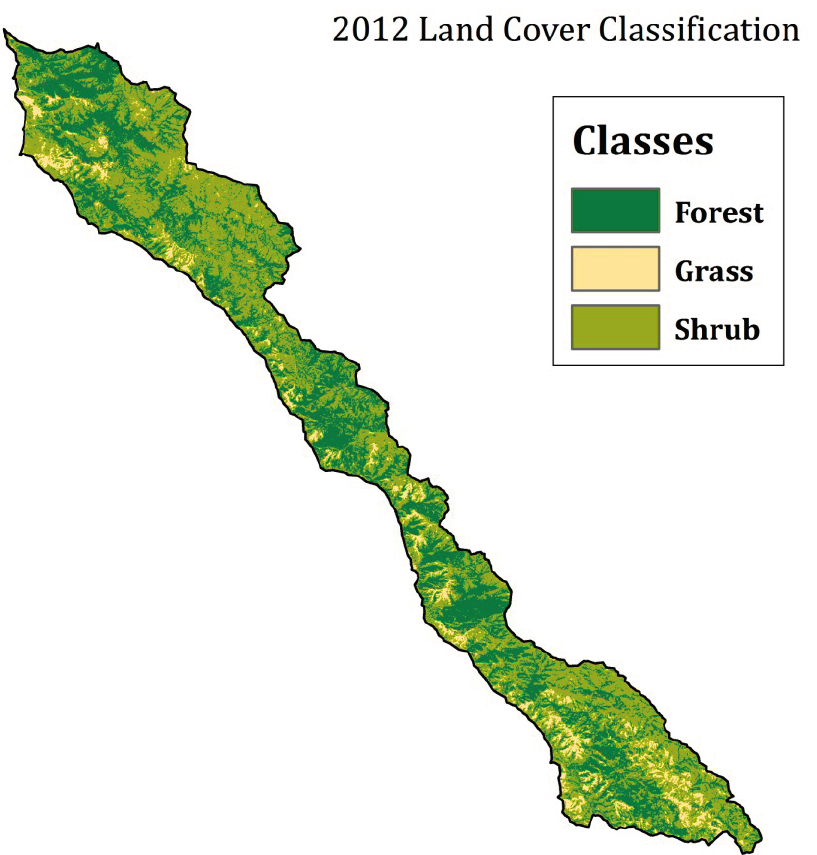
Figure 3. Classification map produced from the 2012 Landsat data that had the highest overall